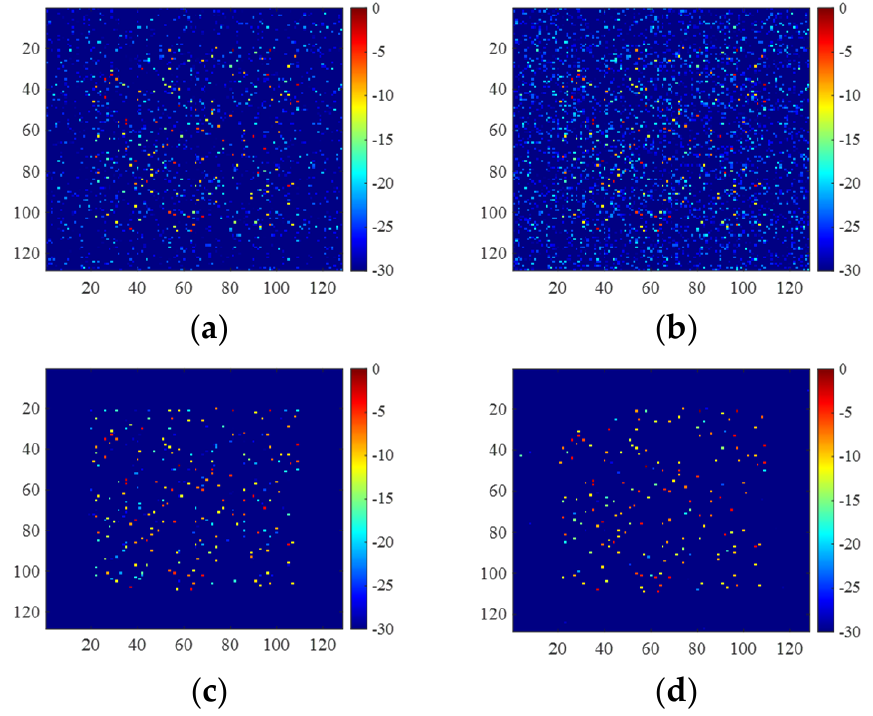
Figure 15. Images of the 2D incomplete data with data missing pattern shown in Figure 8e, which are obtained by ( a ) 2D-FISTA, ( b ) untrained 2D-ADN, ( c ) UNet, and ( d ) trained 2D-ADN.